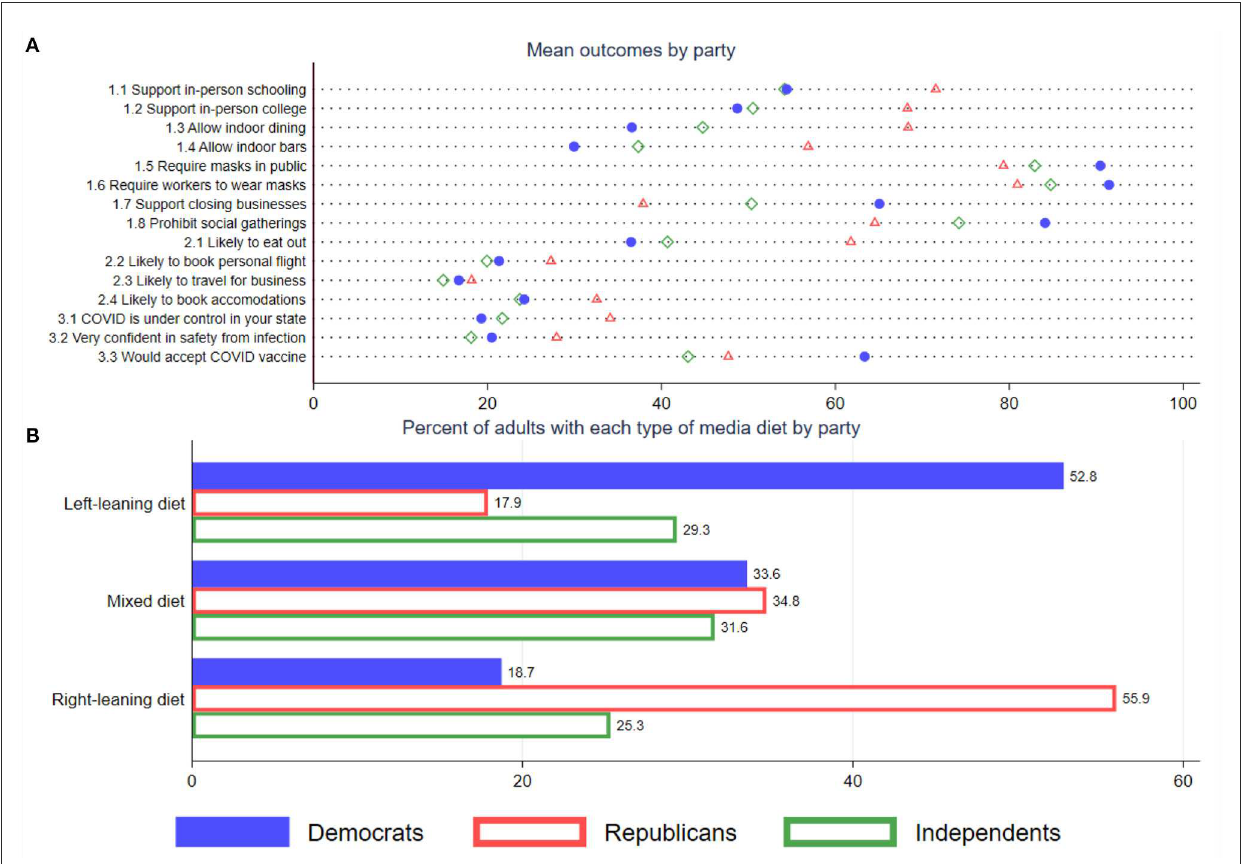
FIGURE1 Heterogeneity in COVID-19 attitudes and news diet, by political affiliation. Data are from the Franklin-Templeton Gallup Economics of Recovery Study, fielded between December 1-7, 2020 with 5,009U.S. adults responding. (A) reports the sample-weighted summary response to 15 outcomes coded on a binary scale by respondent political orientation. Numeric label distinguishes between (1) policies, (2) consumer behavior, and (3) beliefs. Independents include those who favor no party or favor a third party. Responses are weighted to be nationally representative. (B) reports the shares of Republicans, Independents, and Democrats who consume left-leaning, right-leaning, and mixed media diets based on the sources identified in their survey responses. See Supplementary material for further classification